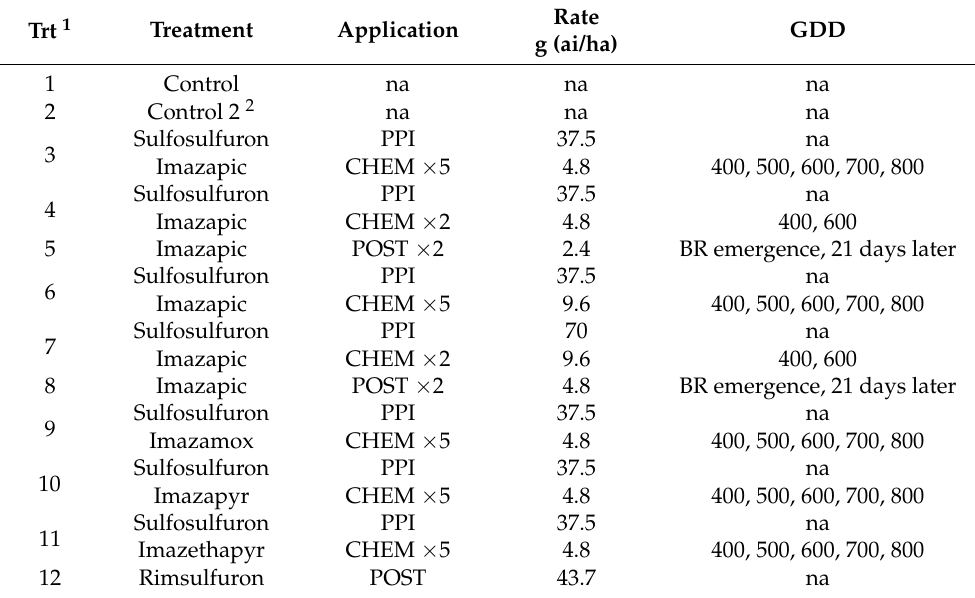
Table 9. Herbicide treatments in a 2020 processing tomato field experiment in Yolo County, CA, USA. Trt 1